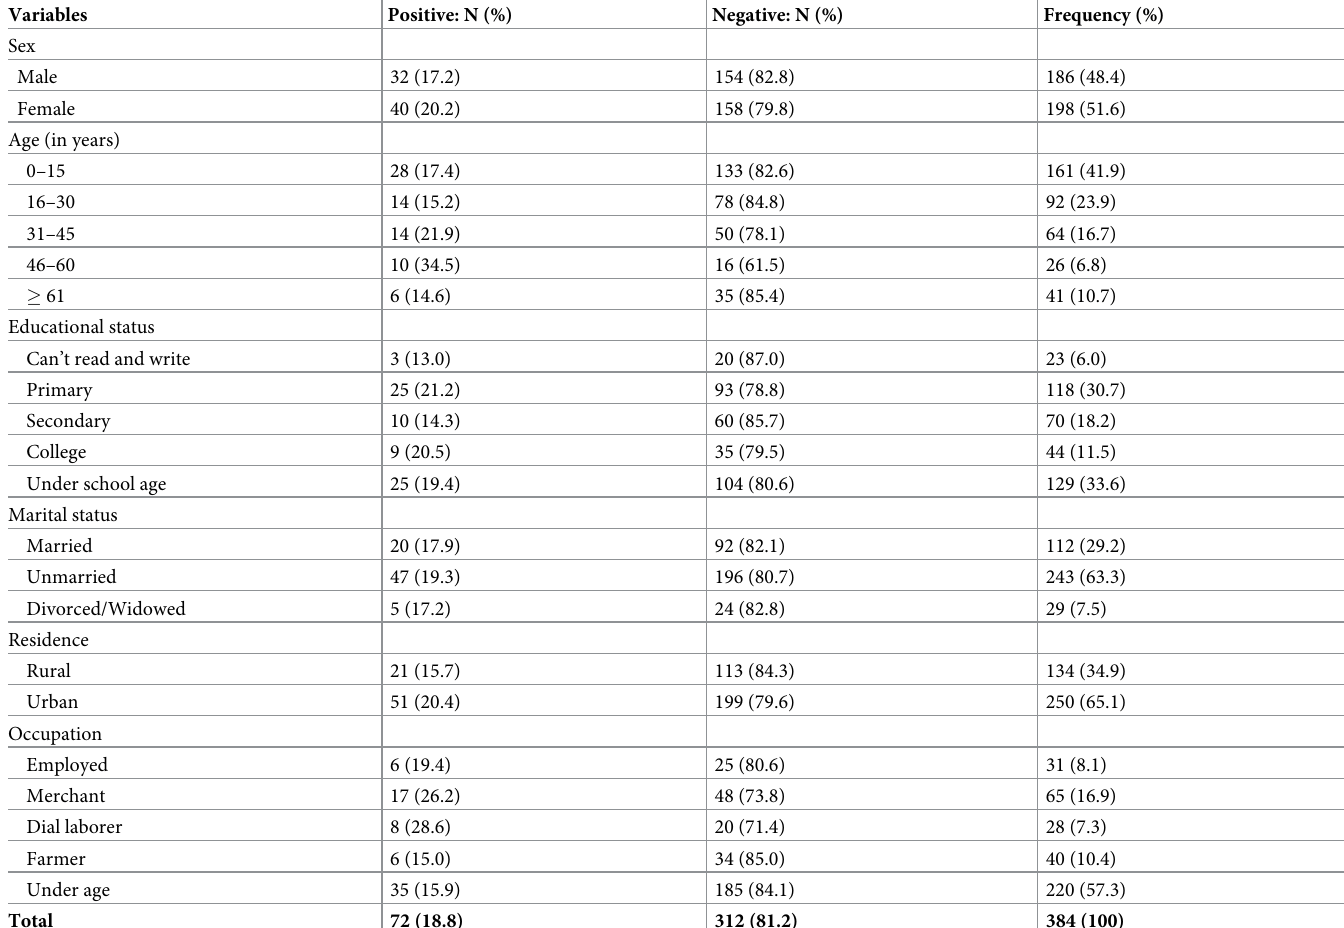
Table 1. Demographic characteristics of study participants (n = 384) and bacterial isolation rate at FHCSH, Bahir Dar, Ethiopia,